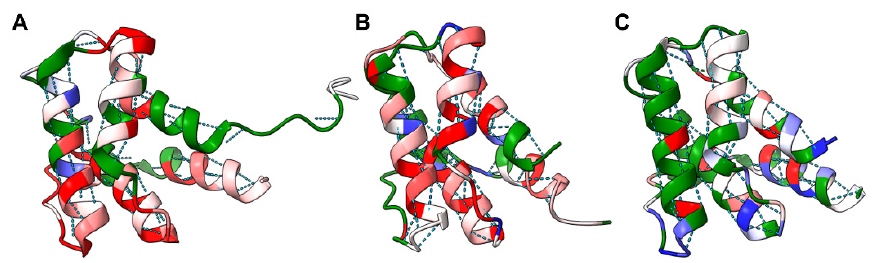
Figure 4. F-scores comparing UniProt ID Q8ZRJ2 backbone heavy atom coordinate uncertainties and variances. ( A ) The first model in the NMR “ensemble” 2JN8, ( B ) final snapshot of the MD trajectory seeded with 2ES9 (replacing Se-MET residues with MET residues, ran at 300 K with the AMBER 99SB forcefield), and ( C ) crystallographic structure, PDB ID 2ES9, each colored on a per residue bases by the F-score described in the Materials and Methods section (Equation (1)). Red indicates an F-score greater than 10 (relative uncertainty, variance, or B-factor of carbonyl oxygen coordinates quite high), white an F-score equal to 1 and blue and F-score less than 0.1. Green indicates residues for which the carbonyl oxygen coordinate uncertainty, variance, or B-factor for the carbonyl oxygen was actually less than the uncertainty, variance, or B-factor for the corresponding amide nitrogen. Dotted lines indicate hydrogen bonds: carbonyl oxygen atoms with high relative coordinate uncertainties and variances occur in both a hydrogen-bonded secondary structure as well as in loop regions. Some helical regions, likely endowed with extra restraints in the NMR- based structure determination process, do have slightly fewer carbonyl oxygens with high relative coordinate uncertainty as compared with the MD trajectory, illustrating the potential importance of hydrogen bonding in “fixing” the position of carbonyl oxygen atoms with high relative coordinate variances. By comparison, the crystallographic structure, PDB ID 2ES9, has relatively few carbonyl oxygens with high relative B-factors as indicated by the relative dearth of red in panel ( C